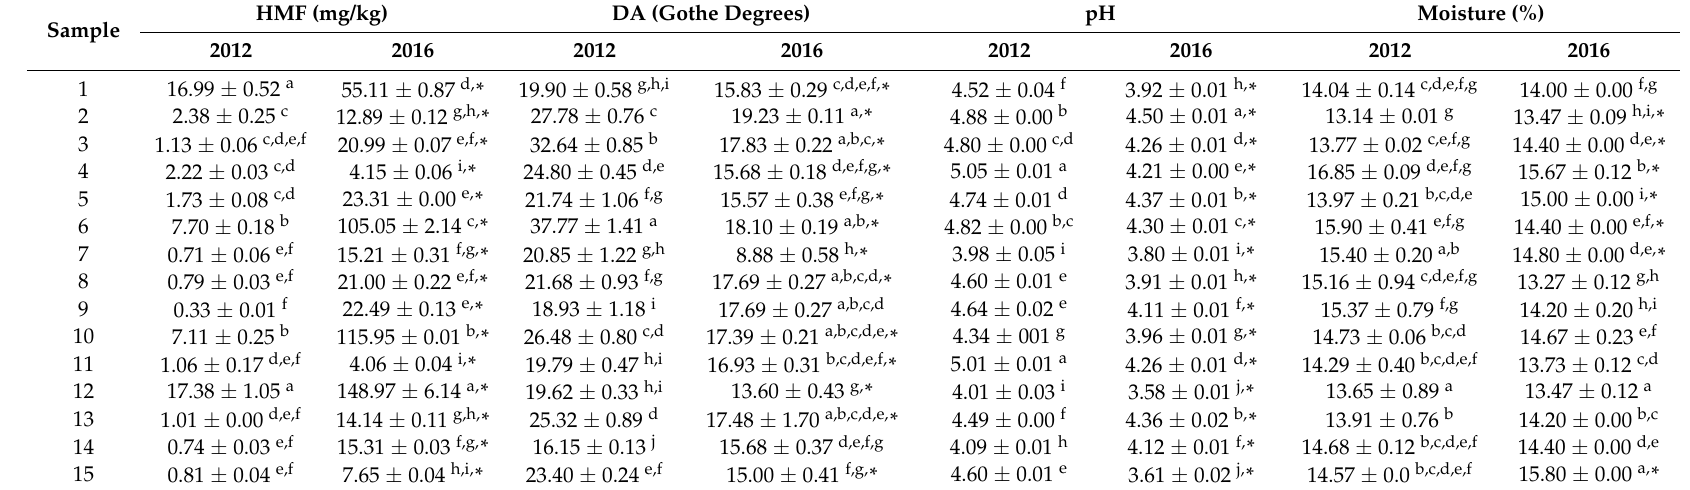
Table 1. Physicochemical parameters of honey samples in 2012 and 2016 (mean ± standard deviation, n = 3).